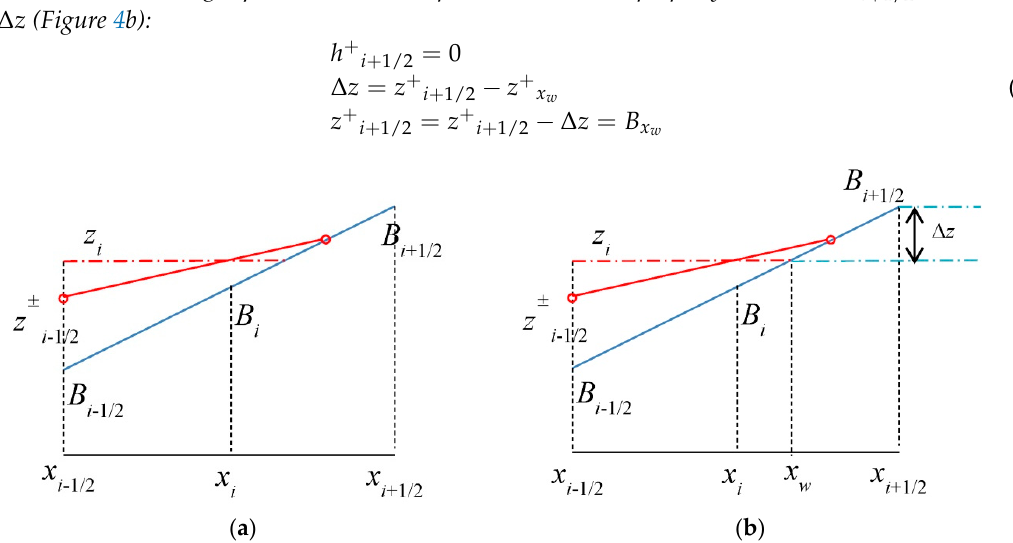
Figure 4. Linear reconstruction with negative h − i + 1/2 for the partially flooded cell. ( a ) Without correction; ( b ) correction of values at the i + 1/2 interface.